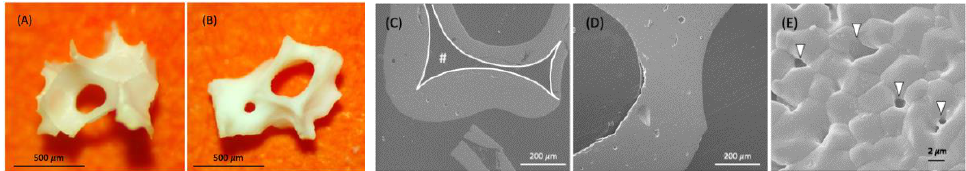
Figure 2. Digital and SEM comparison images between InRoad ( A , C , E ) and Bio-Oss ( B , D ). Both graft types similar under stereo microscope ( A , B ). Cross-section image under SEM showed distinguishable difference in internal structure; InRoad showed an embedded micro-channel ( C ) and Bio-Oss did not ( D ). Micro-sized holes (arrowhead) were observed on the InRoad surface ( E ).